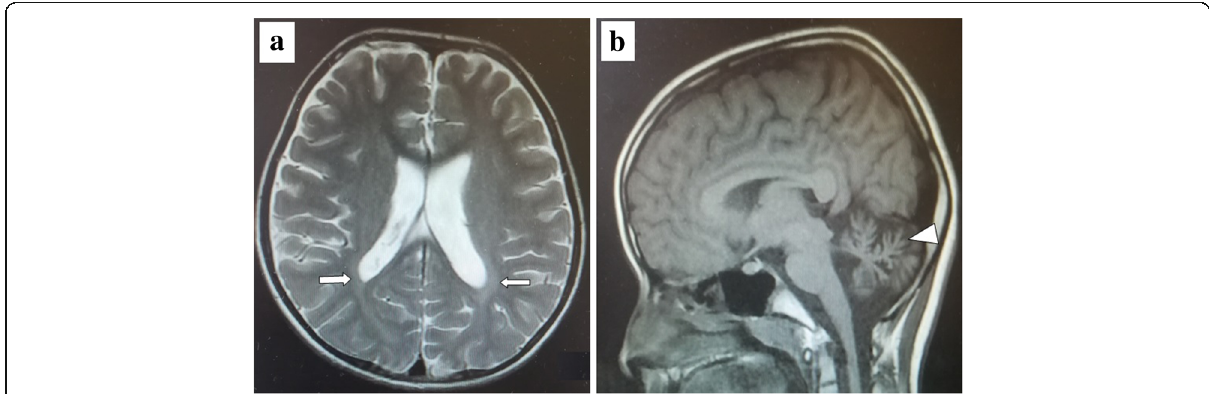
Fig. 2 The brain MRI images. a T2-weighted brain MRI image shows high signals adjacent to the bilateral posterior horns of the lateral ventricles (arrows). b T1-weighted brain MRI image shows broadened cerebellar fissures